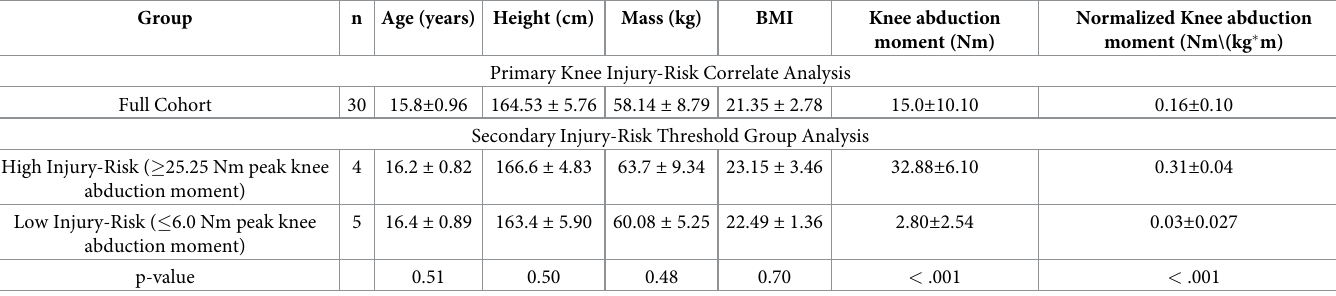
Table 1. Group demographics and motor performance